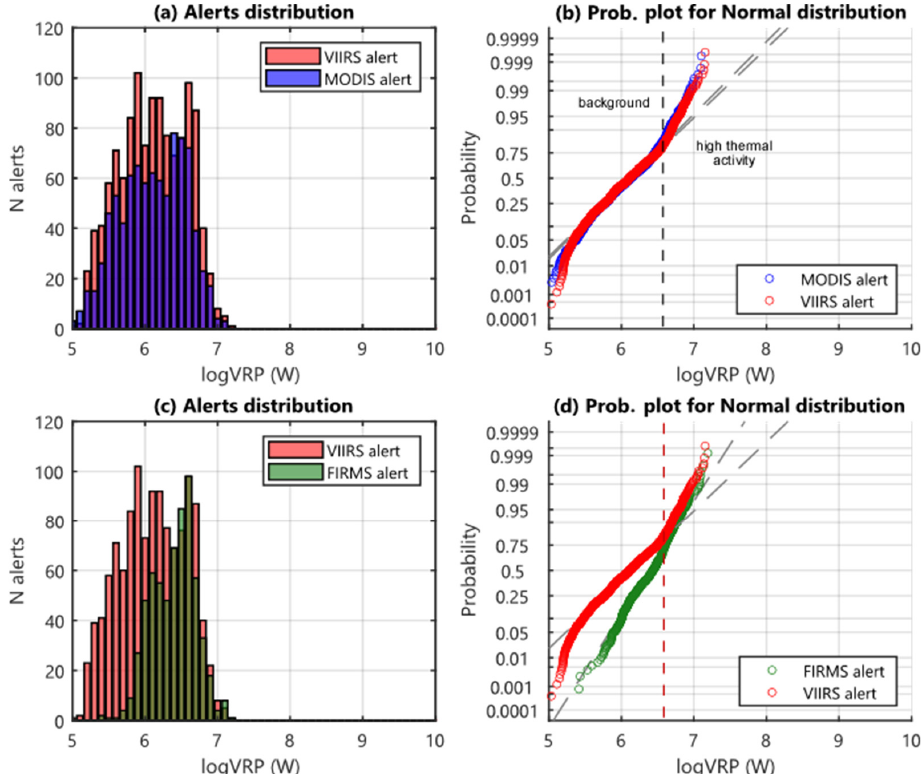
Figure 5. Histograms ( a , c ) and probability plots ( b , d ) for Láscar datasets. ( a , c ) Histograms display data distribution related to VRP (and FRP) in logarithmic scale (0.1 MW–1 GW), with a range between the classes of 0.1 bins; blue bars represent the distribution of MIROVA MODIS data, the red ones represent MIROVA VIIRS data, and green bars represent FIRMS VIIRS data. ( b , d ) Probability plots for normal distribution of MIROVA VIIRS (red), MIROVA MODIS (blue), FIRMS VIIRS (green) datasets; the dashed grey lines represent the reference lines of the theoretical distributions, and the black dashed line in ( b ) corresponds to the threshold between the background fumarolic activity and the higher thermal activity characterizing the eruptive phases. In ( d ) the red dashed line represents the slope change connected to the passage between the regimes of background and high thermal activity, detected only by the MIROVA VIIRS algorithm. The probability plot of FIRMS data doesn’t show any significant changes, due to the low sensitivity of the algorithm on detecting volcano-derived low thermal anomalies.